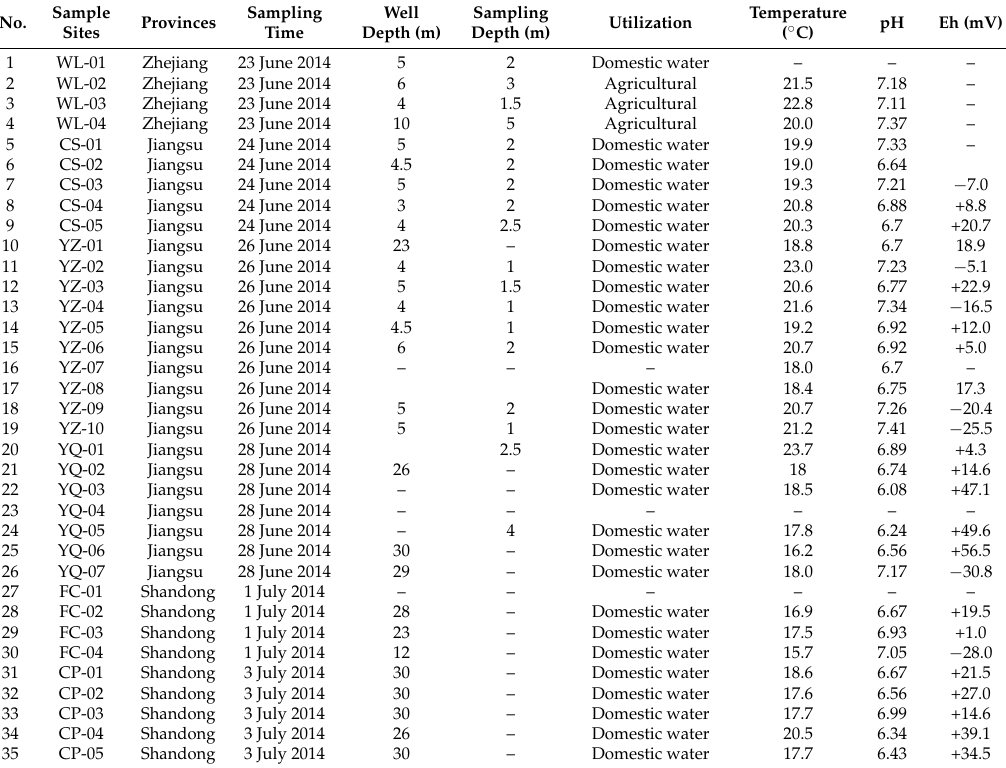
Table 1. Physicochemical properties of the groundwater